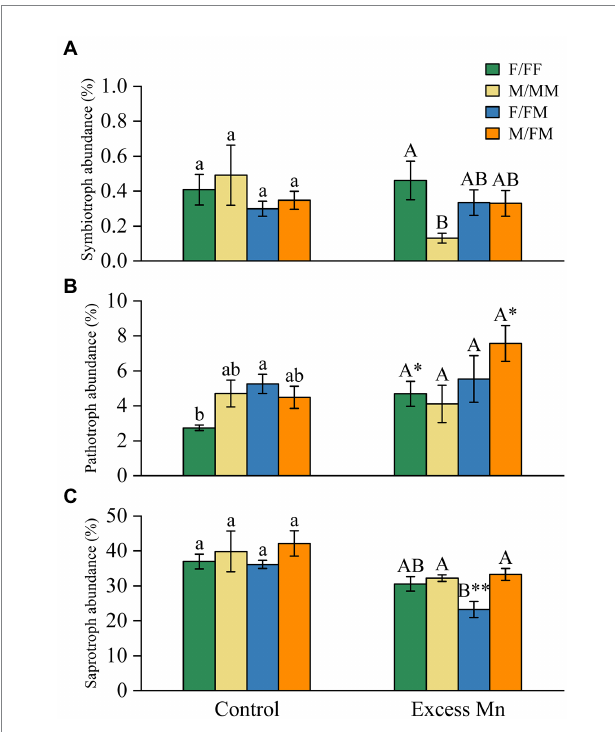
FIGURE 4 Relative abundances of symbiotrophs (A) , pathotrophs (B) , and saprotrophs (C) under different sexual competition patterns and Mn treatments. The asterisks indicate significant differences between control and Mn treatments within each competition treatment according to an independent-samples t-test (* P < 0.05, **0.001 < P ≤ 0.01). Values are means ± SE ( n = 4). Treatment codes and statistical significance codes are the same as in Table